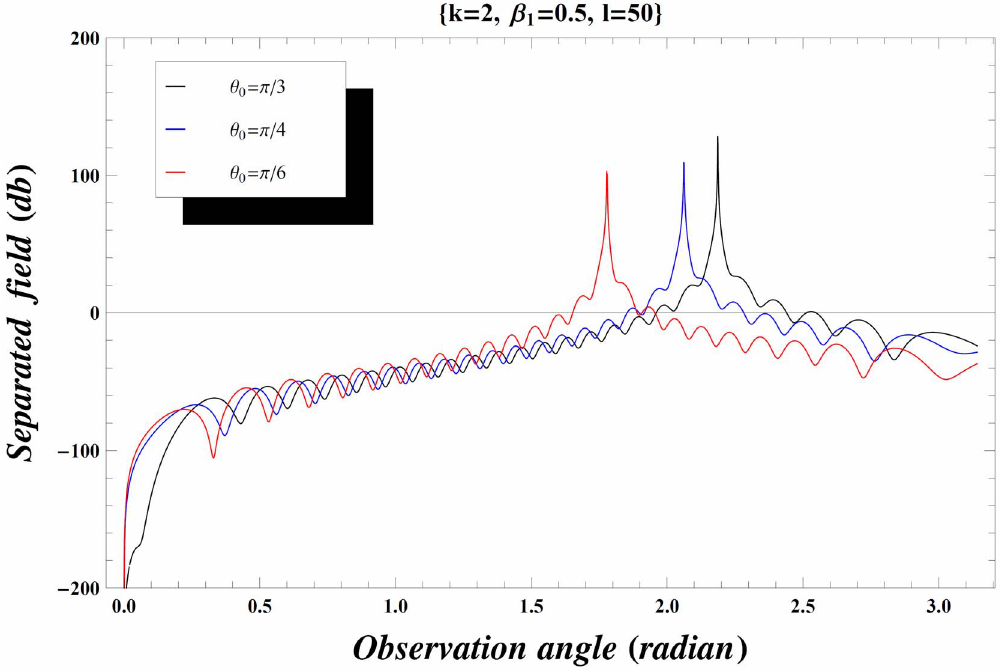
Figure 5. Separated field versus observation angle for different values of incidence angle h 0 when k ~ 3 and plate length l ~ 50 .